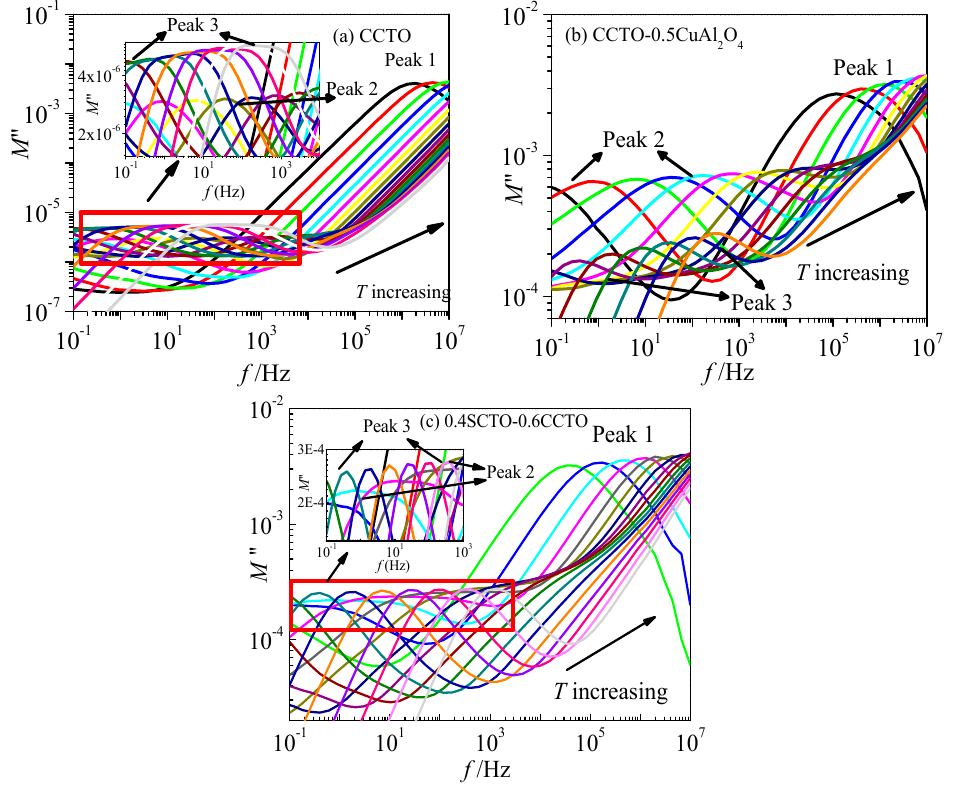
Table 1. Electrical parameters of CCTO ceramics of undoped CCTO ceramics and CaCu 3 Ti 4 O 12 /CuAl 2 O 4 composite ceramics.